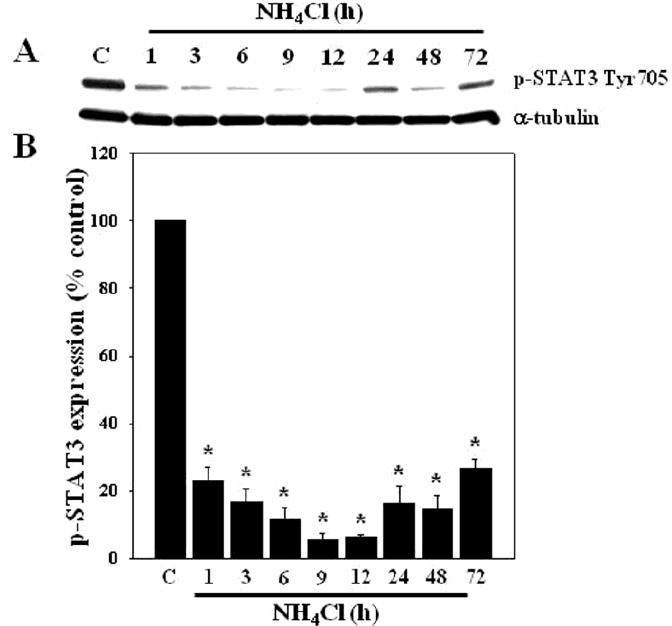
Figure 1. Effect of ammonia on STAT3 Tyr705 phosphorylation in cultured astrocytes. ( A ) Immunoblots of phosphorylated STAT3 Tyr705 obtained at different time points after ammonia treatment. STAT3 was dephosphorylated after ammonia treatment (NH 4 Cl; 5 mM) at all time points examined (0–72 h); ( B ) Quantification of STAT3 phosphorylation. Data were subjected to ANOVA followed by Tukey‘s post hoc comparison test ( n = 4). * p < 0.05 vs. control. Error bars, mean ± S.E. C, control.